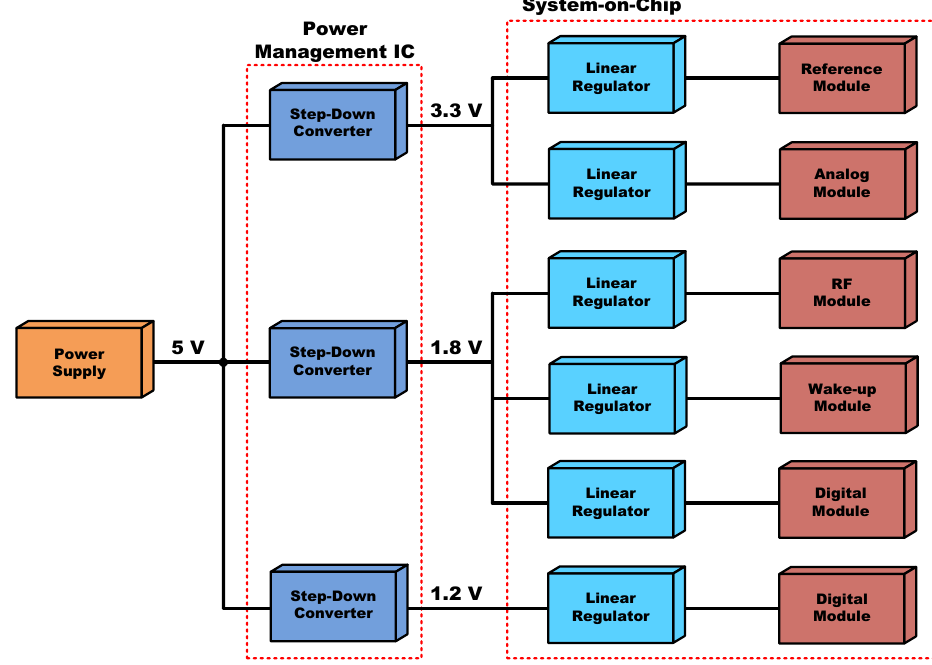
Figure 21. Block diagram showing general architecture of power supply in a SoC